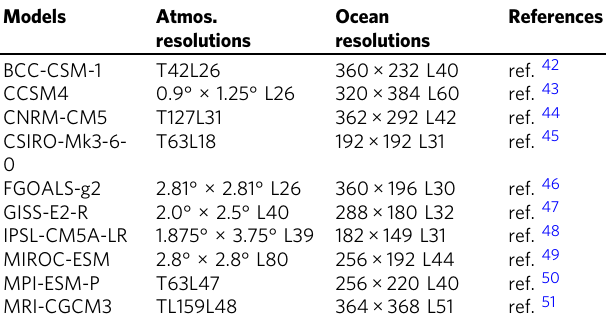
Table 1 Summary of the PMIP3 (mid-Holocene) and